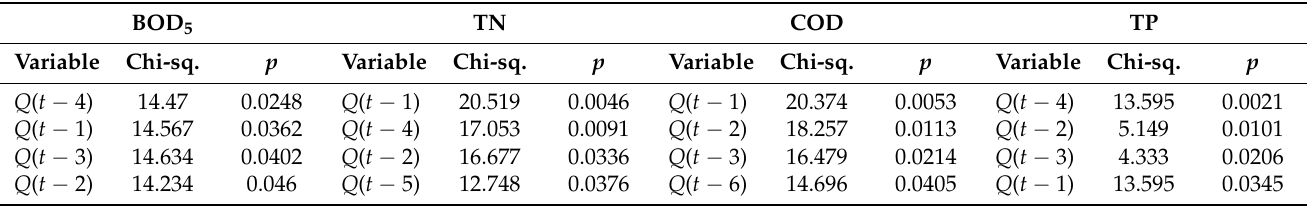
Table 3. List of Chi-squared test values and p-test probabilities for variables describing wastewater quality indicators (BOD 5 , COD, TN, TP ) in models for identifying maximum C ( { t ) } f values for the Sitk ó wka-Nowiny treatment